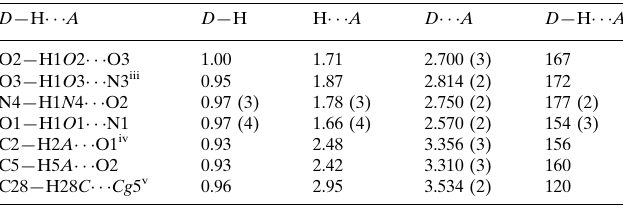
Hydrogen-bond geometry (A˚ , (cid:2)